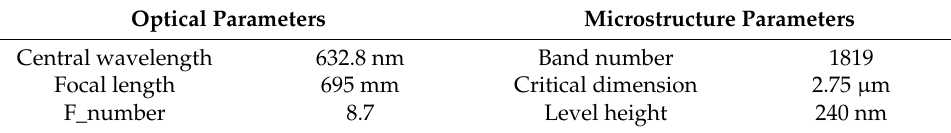
Figure 2. Preparation of the PI membrane. ( a ) Process of repeated spin-coating. ( b ) Membrane-thickness variation with different parameters: spin speed and solute concentration and fluid viscosity. ( c ) Image and characteristic parameters of PI membrane in the free state. Table 1. Optical and dimension parameters.